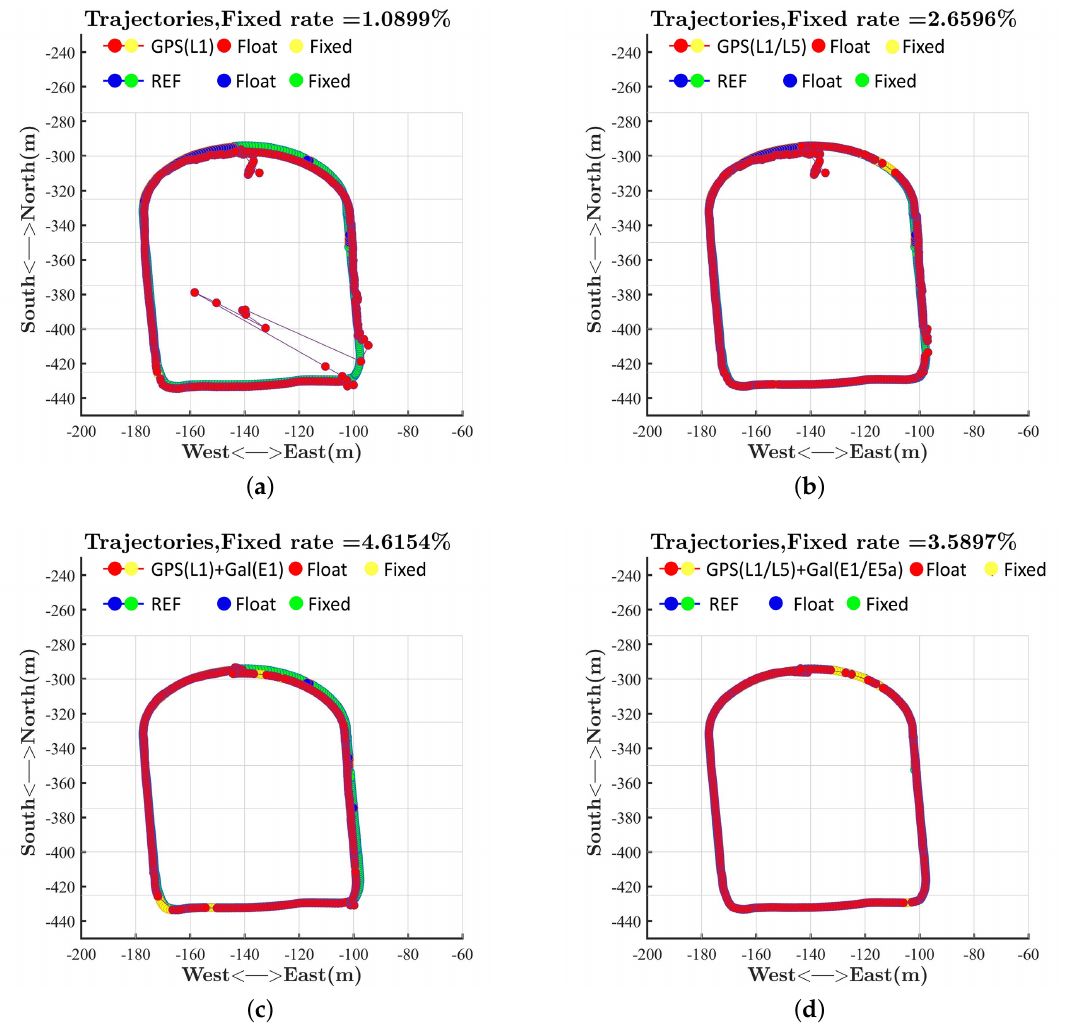
Figure 8. RTK performances on the sports ground. ( a ) GPS(L1); ( b ) GPS(L1 + L5); ( c ) GPS(L1) + Galileo(E1); ( d ) GPS(L1 + L5) + Galileo(E1 +